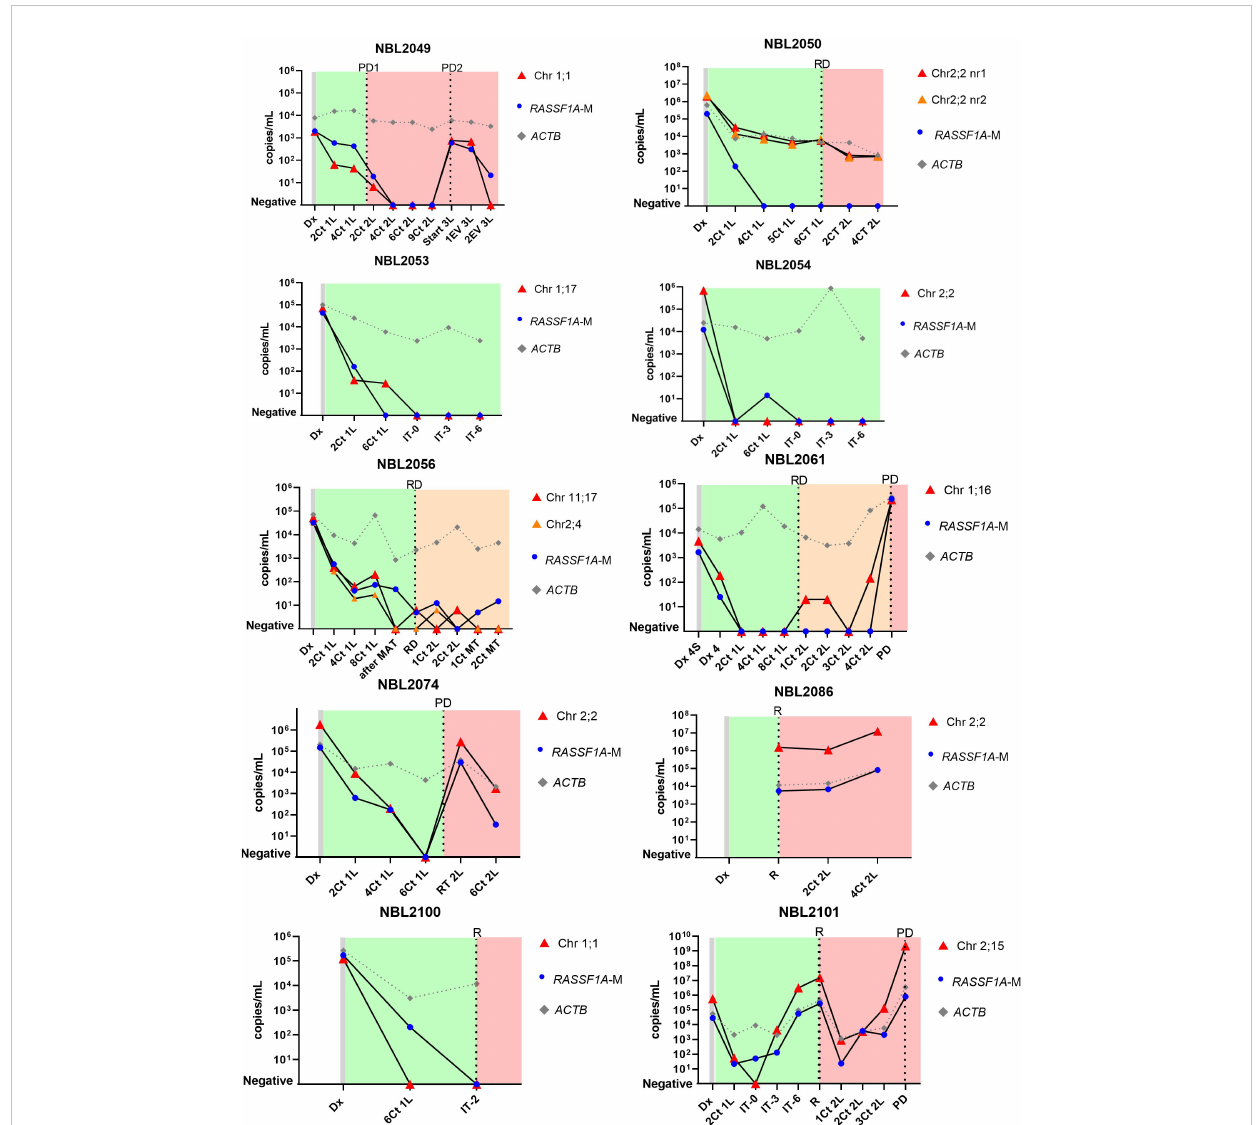
FIGURE 4 Levels of patient-speci fi c targets, reference gene ACTIN beta (ACTB) and methylated RASSF1A (RASSF1A-M) in cell-free DNA (cfDNA) from 10 neuroblastoma patients at diagnosis and during the course of the disease. Dx, diagnosis; Dx 4S, diagnosis INSS stage 4S; Dx 4, diagnosis INSS stage 4; nCt 1L, after n courses in fi rst line therapy; nCt 2L, after courses in second line therapy; 3L, third line therapy; 1EV 3L, fi rst evaluation third line therapy; 2EV 3L, second evaluation third line therapy; IT-0, before GD-2 immunotherapy IT-3 after 3 cycles of GD-2 immunotherapy; IT-6, after 6 cycles of GD-2 immunotherapy; MAT, myeloablative therapy and autologous stem cell transplantation; RT 2L, after radiotherapy during second line therapy; MT, maintenance treatment. PD, progressive disease; R, relapse; RD, refractory disease. Green blocks indicate fi rst line treatment, orange blocks indicate added treatment for refractory disease, red blocks indicate treatment for progressive or relapsed